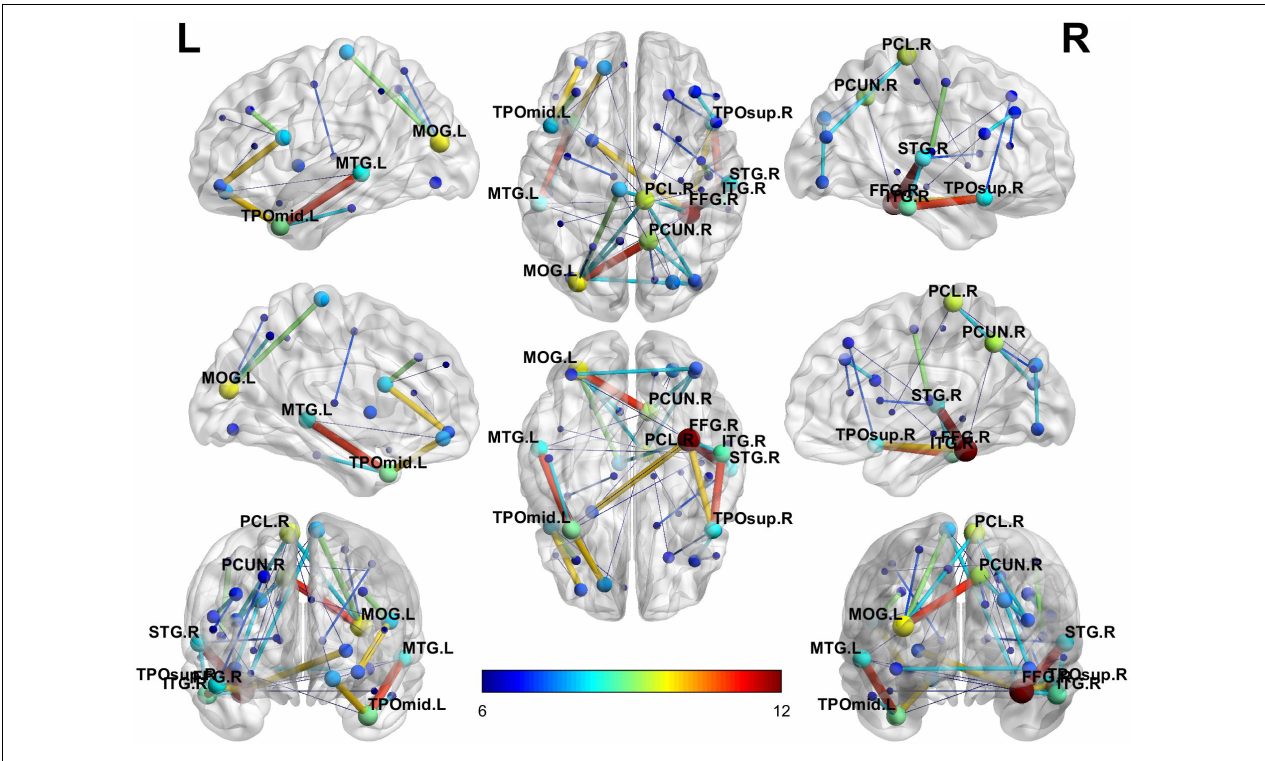
FIGURE 3 | Full-view diagram of key features with weights greater than or equal to 6. TABLE 6 | Effect of features with different weights on AD